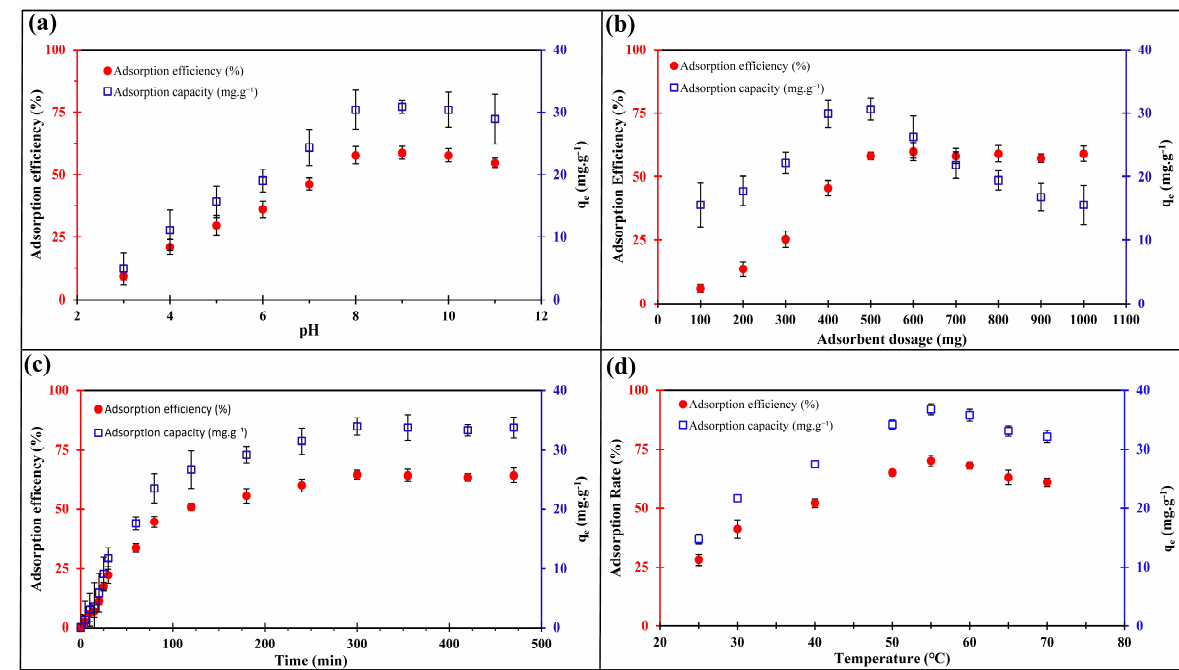
Figure 3. ( a ) Effect of pH (conditions: 50 mL of 1000 mg L − 1 real sample, 0.5 g of ZIF-8, temperature 50 ◦ C, and 240 min of contact time), ( b ) adsorbent dosage (conditions: 50 mL of 1000 mg L − 1 real sample at pH = 8, temperature 50 ◦ C, and 240 min of contact time), ( c ) contact time (conditions: 50 mL of 1000 mg L − 1 real sample at pH = 8, 0.5 g of ZIF-8, and temperature 50 ◦ C), and ( d ) temperature (conditions: 50 mL of 1000 mg L −1 real sample at pH = 8, 0.5 g of ZIF-8, and 300 min of contact time) of the adsorption efficiency of heparin over ZIF-8.